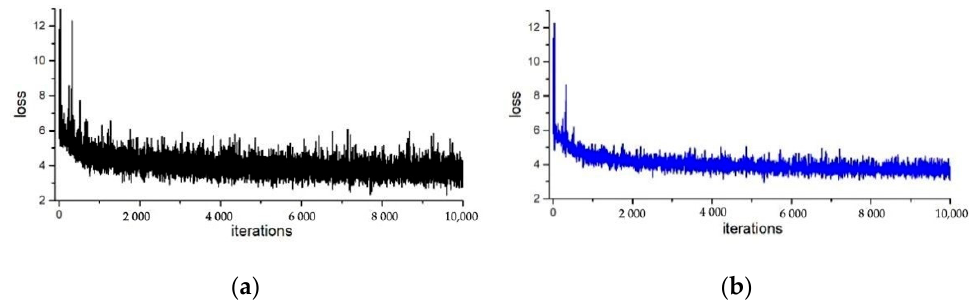
Figure 4. The loss curve of the ResNet50 network without and with the adaptive weighting.